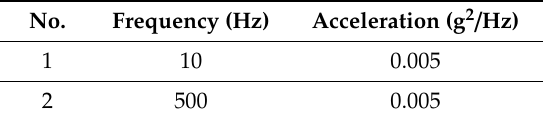
Table 1. Test profile for random excitation.